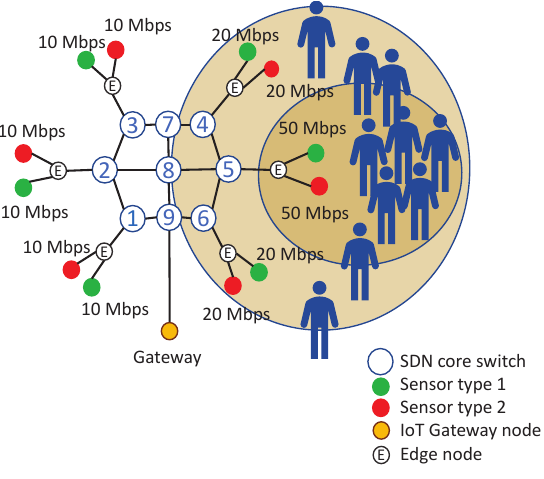
Figure 5. The traffic rate of sensors after the crowd moved to the edge of core node